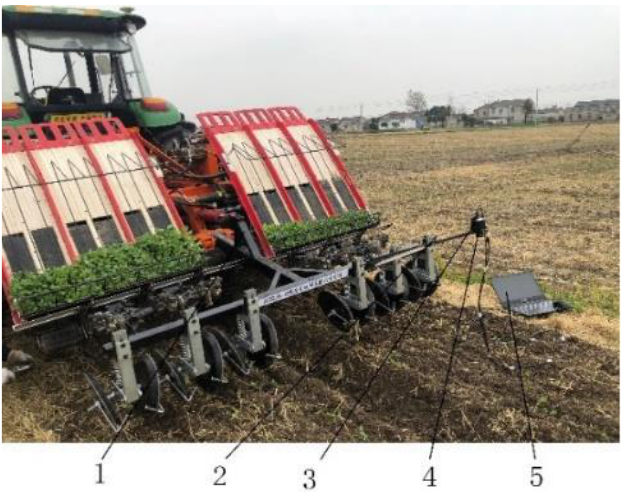
Figure 1. Seedling cavitation and lodging monitoring system. (1) 2ZGZK-6 rape blanket seedling transplanter, (2) Bracket, (3) Industrial camera and lens, (4) Ranging sensor, (5) Industrial personal